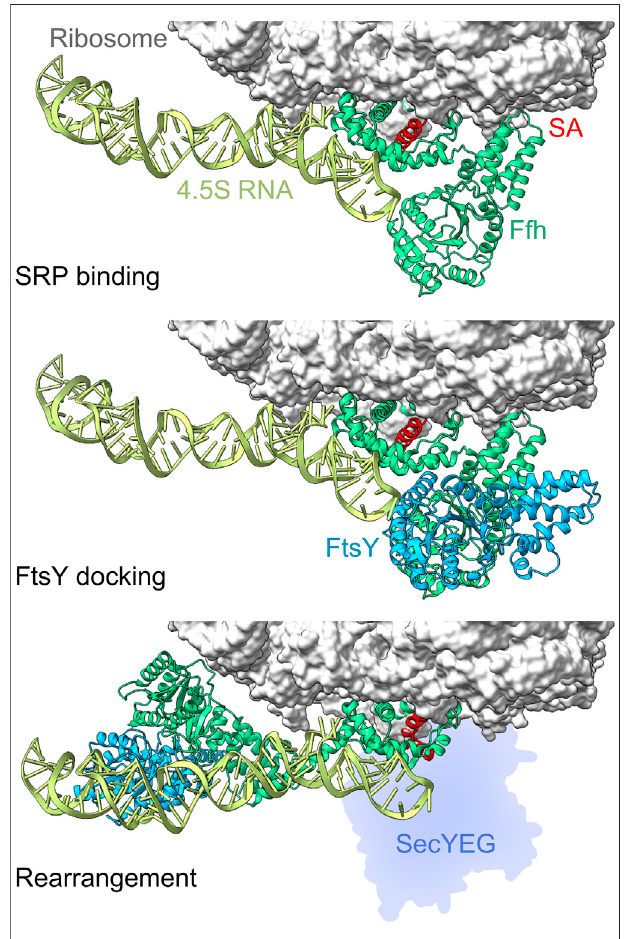
FIGURE 2 | Conformational rearrangements of SRP and FtsY on the ribosome. Top panel: cryo-EM structure of the SRP binding complex at the ribosome with the M-domain of Ffh (green) recognizing the signal-anchor sequence (SA, red) emerging from the ribosome (gray). Ffh NG domain contacts the proximal end of the 4.5S RNA while the M-domain interacts with ribosomal proteins uL23 and uL29 as well as the 23S rRNA (PDB 5GAF (Jomaa et al., 2016)). Middle panel: Initial docking of FtsY on the RNC-SRP complex involves interactions between the NG domains of FtsY (blue) and Ffh (green) (PDB 5GAD (Jomaa et al., 2016)). Bottom panel, NG domains of Ffh and FtsYrelocatetowardsthedistalendofthe4.5SRNA(PDB5NCO(Jomaa etal.,2017)),promotinghandoveroftheRNCtothetranslocon(silhouette;not in the structure, inferred from PDB 5GAE (Jomaa et al.,